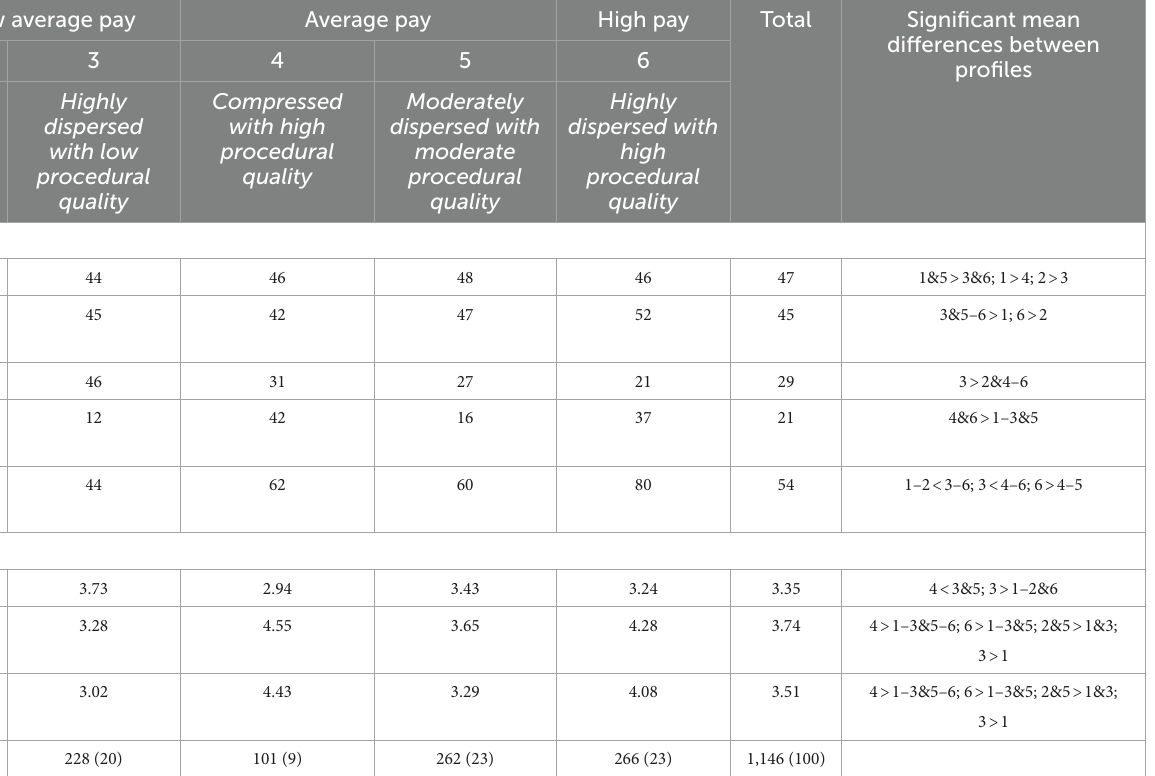
Significant differences between profiles based on Wald χ 2 below p <